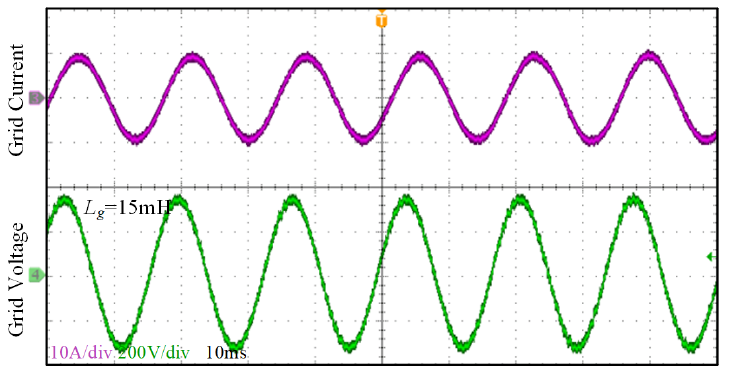
Figure 19. Waveform of grid voltage and grid-connected current when the grid impedance is 15 mH.